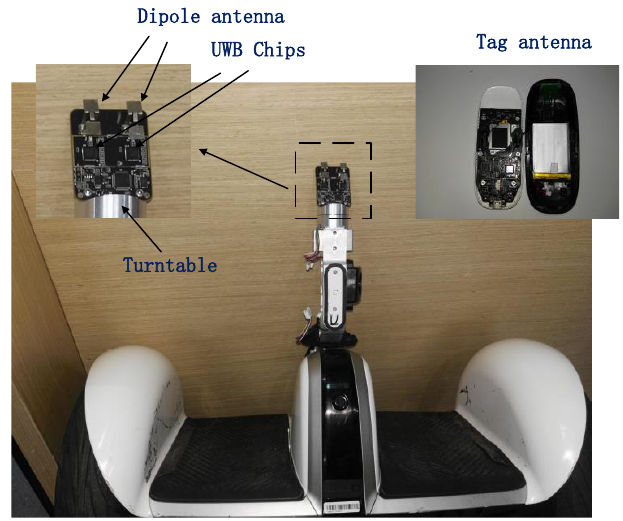
Figure 23. Proposed auto-tracking antenna system installed in a self-balanced two-wheeled vehicle.